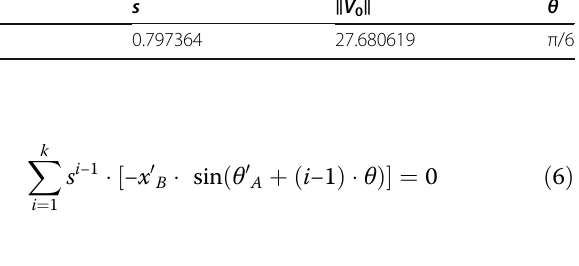
Table 1 The specific data of typical curve for Example 1 k